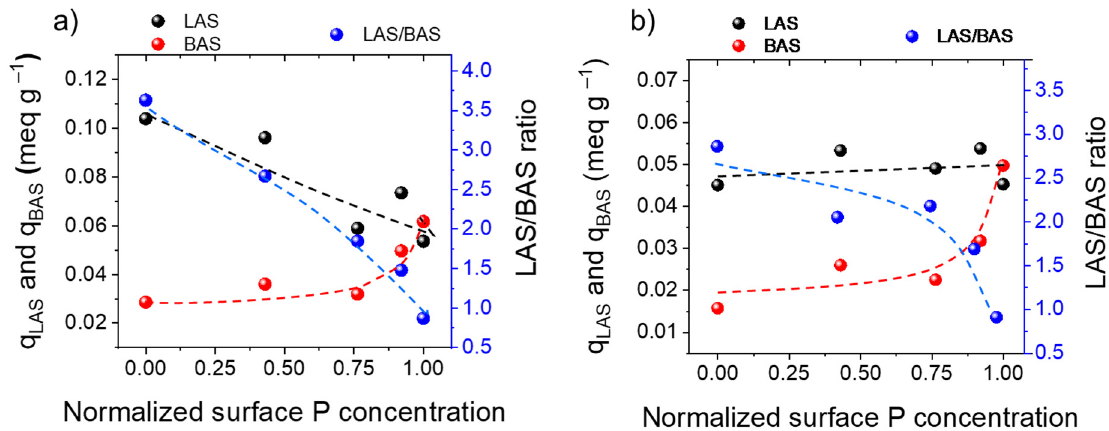
Figure 4. Trends of the amount of LAS and BAS (q LAS and q BAS ) and LAS/BAS ratio against normalized surface P-concentration (obtained from XPS) determined following pyridine desorption at 150 °C in experiments with pyridine vapor ( intrinsic acidity) ( a ); and pyridine aqueous ( effective acidity) ( b ).